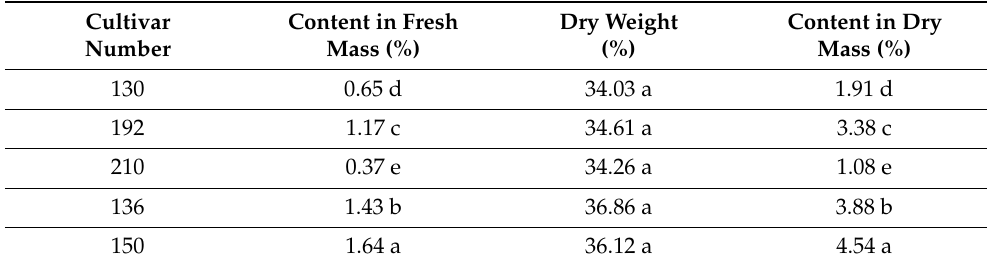
Table 1. Percentage of the fraction of essential oils in fresh and dry samples of five lines of A. balchanorum (vegetative stage). One-way ANOVA and Student’s t -test analyses were applied. Levels not connected by the same letter are significantly different ( α =